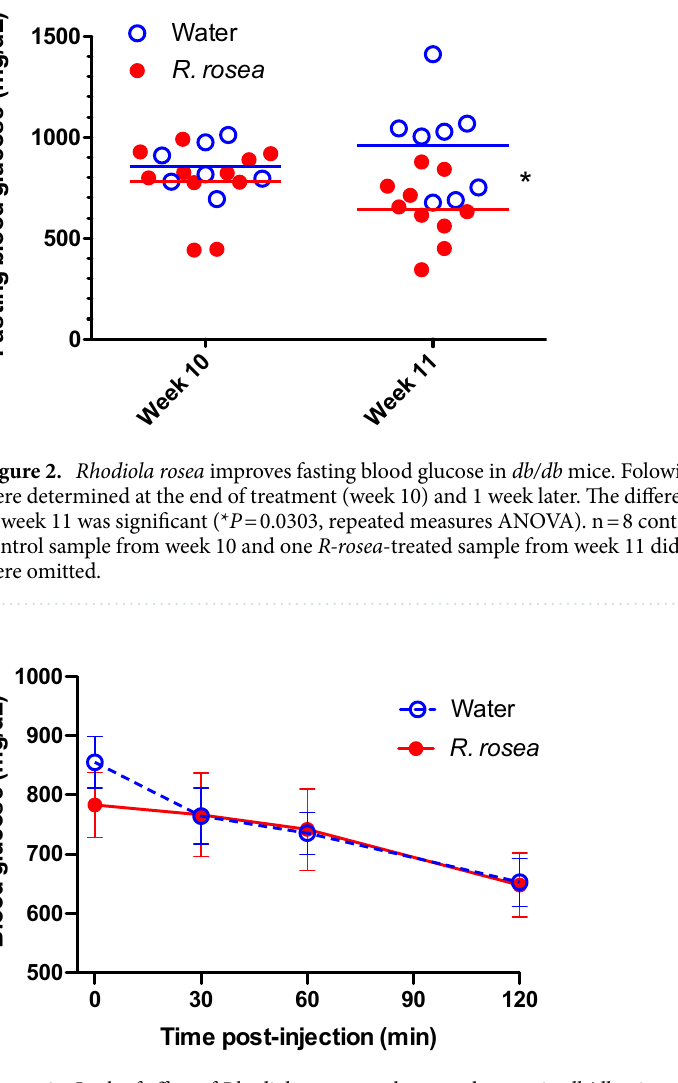
Figure 3. Lack of effect of Rhodiola rosea on glucose tolerance in db/db mice. Cohorts of mice (n = 7 control, n = 11 R. rosea -treated) at the end of the treatment period (week 10) were fasted for 4 h and then challenged with 0.5 g/kg glucose by intraperitoneal injection, followed by determination of blood glucose levels at 30, 60, and 120 min post-injection. None of the differences between control and R. rosea -treated mice were significant (one- way repeated measures